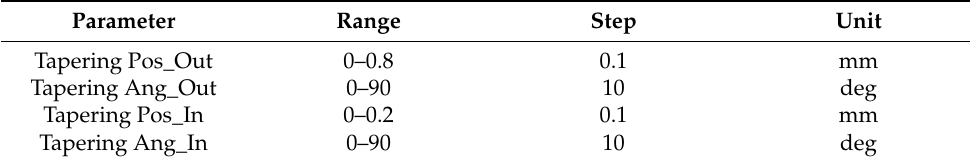
Figure 8. Variable of tapering. Table 3. Variable setting of tapering.